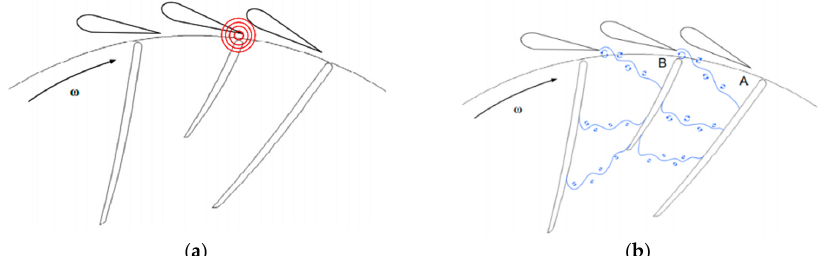
Figure 1. ( a ) Occurrence of a pressure pulse as a runner blade passes through a guide vane cascade; ( b ) GV wake progressing towards the runner. Adapted with permission from Einar Kobro (2010) [11].